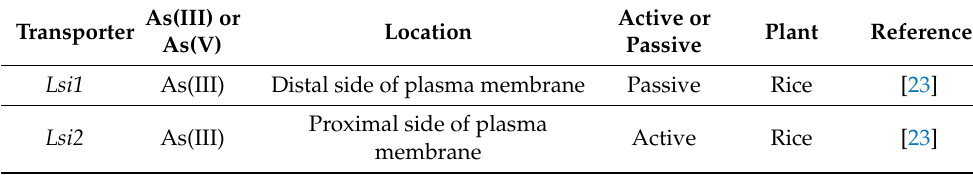
Table 2. Transporter proteins, their location and their function in